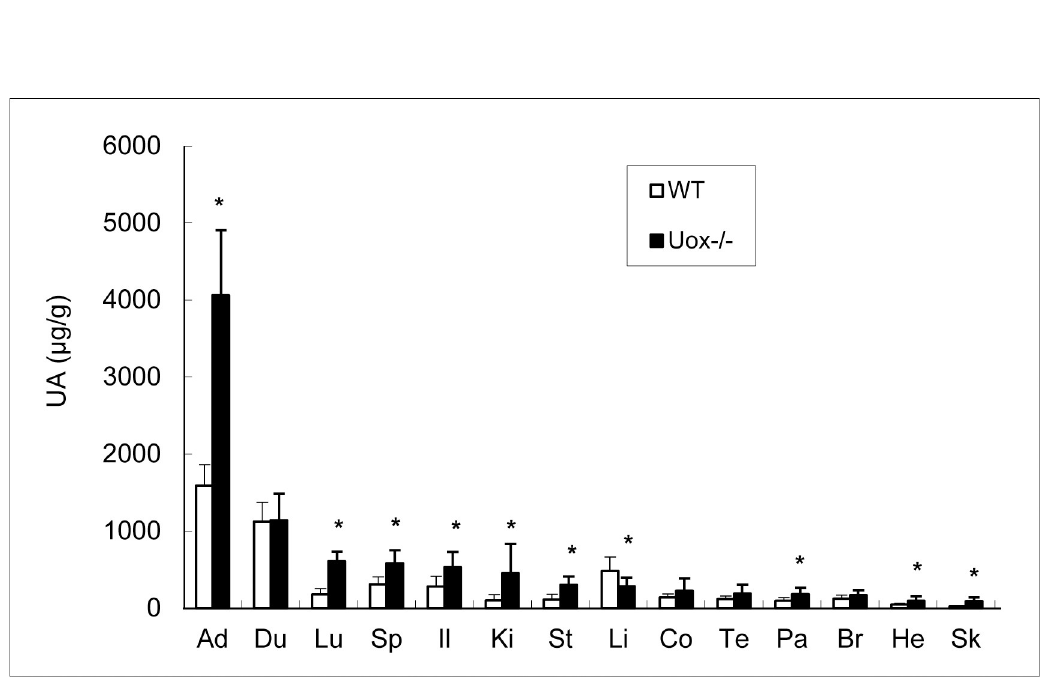
Fig 4. Uric Acid (UA) in the male Wild-Type (WT) and Uox -/- rats’ tissues (Uox -/- ) who weighing 180–220 g [mean ± SD, n = 8 (WT) or = 10 (Uox -/- )]. � P < 0.05, vs WT, one-way ANOVA. Sorted by the uric acid level in Uox -/- rats’ tissues from high to low. Ad, the adrenal gland; Du, the duodenum; Li, the liver; Sp, the spleen; Il, the ileum; Lu, the lung; Co, the colon; Br, the brain; Te, the testicle; St, the stomach; Ki, the kidney; Pa, the pancreas; He, the heart; Sk, the skeleton (gluteus).